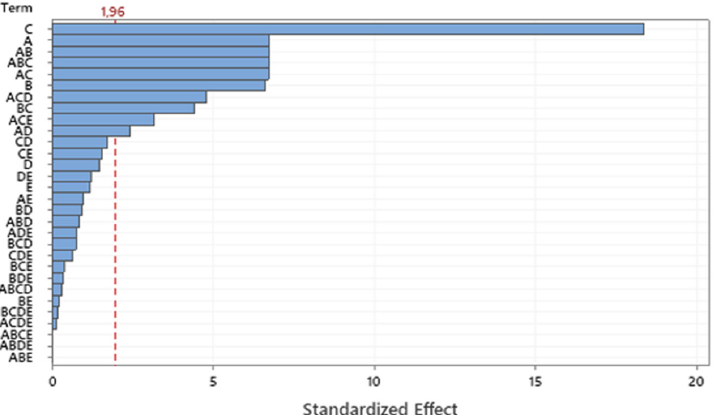
Fig. 14. Pareto chart of the standardized effects (Confidence = 95%). A = instance, B = tabuTenure, C = initialization, D